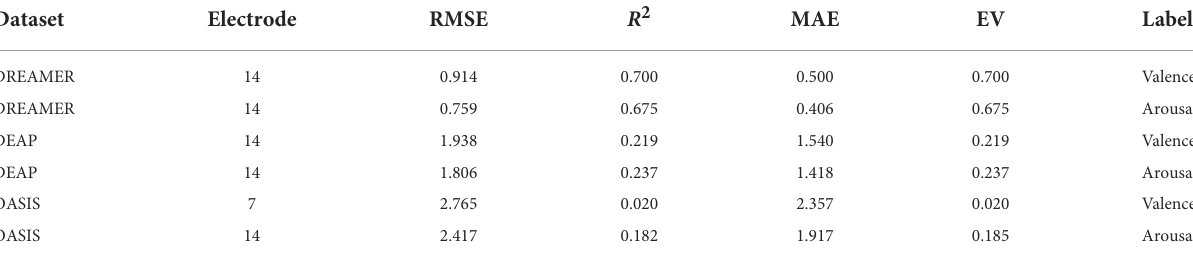
TABLE 5 Regression evaluation metrics values for valence and arousal label on the test set (20%) of DEAP, DREAMER, and OASIS dataset for the optimum set of electrodes. Dataset